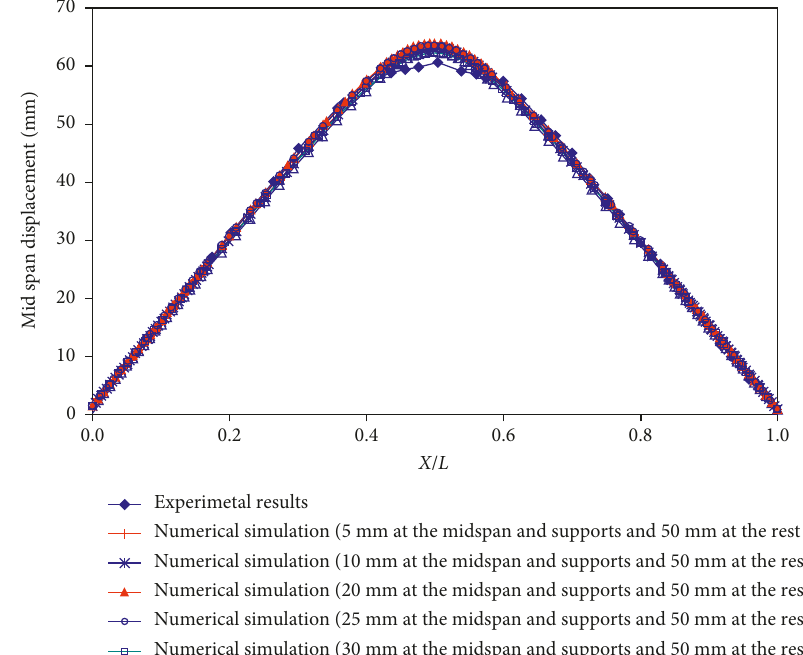
Figure 2: Comparison of the permanent deflected shape of the steel column 4C1 between the experimental test of Nassr et al. [4] and the present numerical simulation using different mesh Table 2: Failure parameters used in the present model. Fracture strain